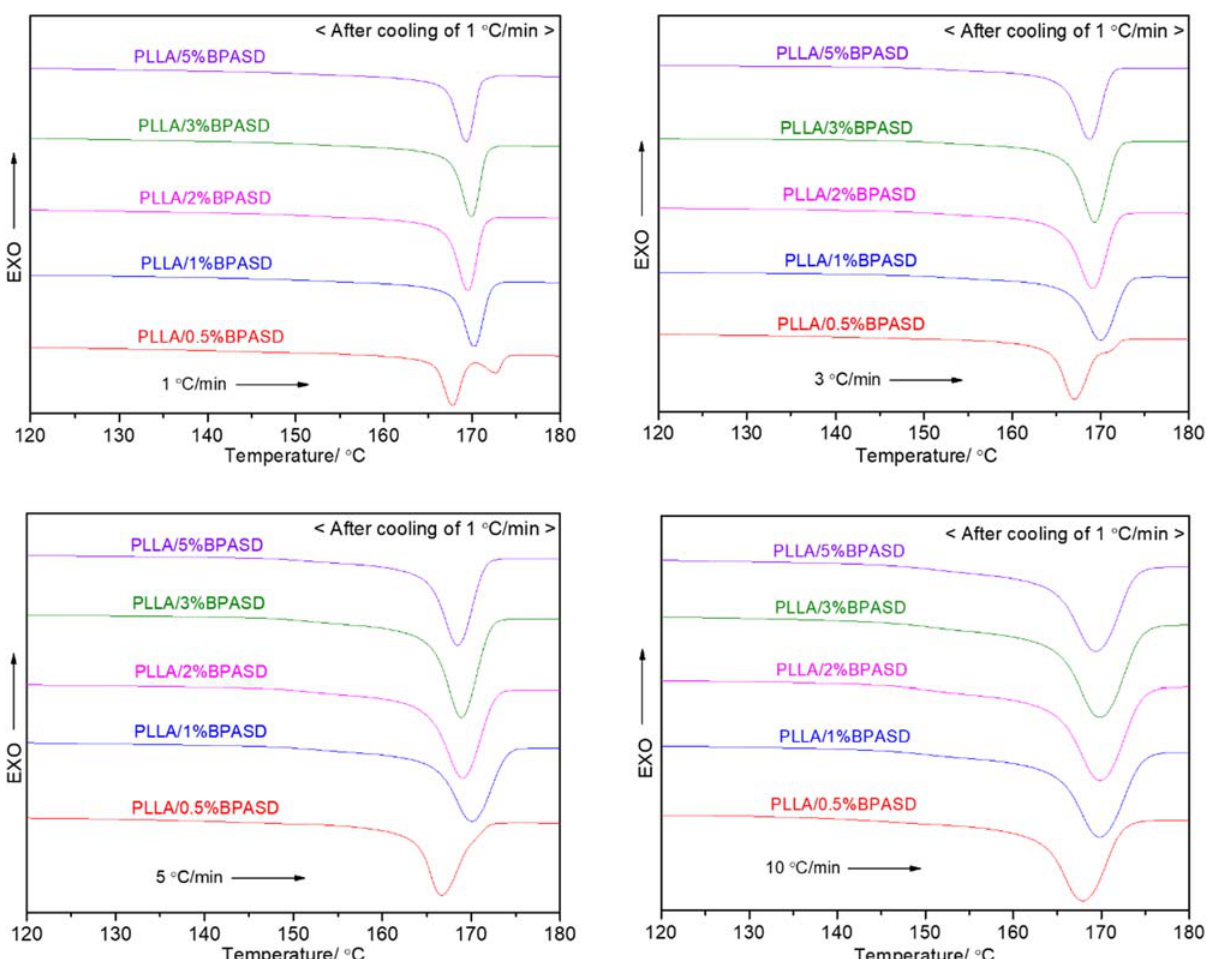
Figure 7: Melting behavior of PLLA/BPASD samples at di ff erent heating rates after melt -